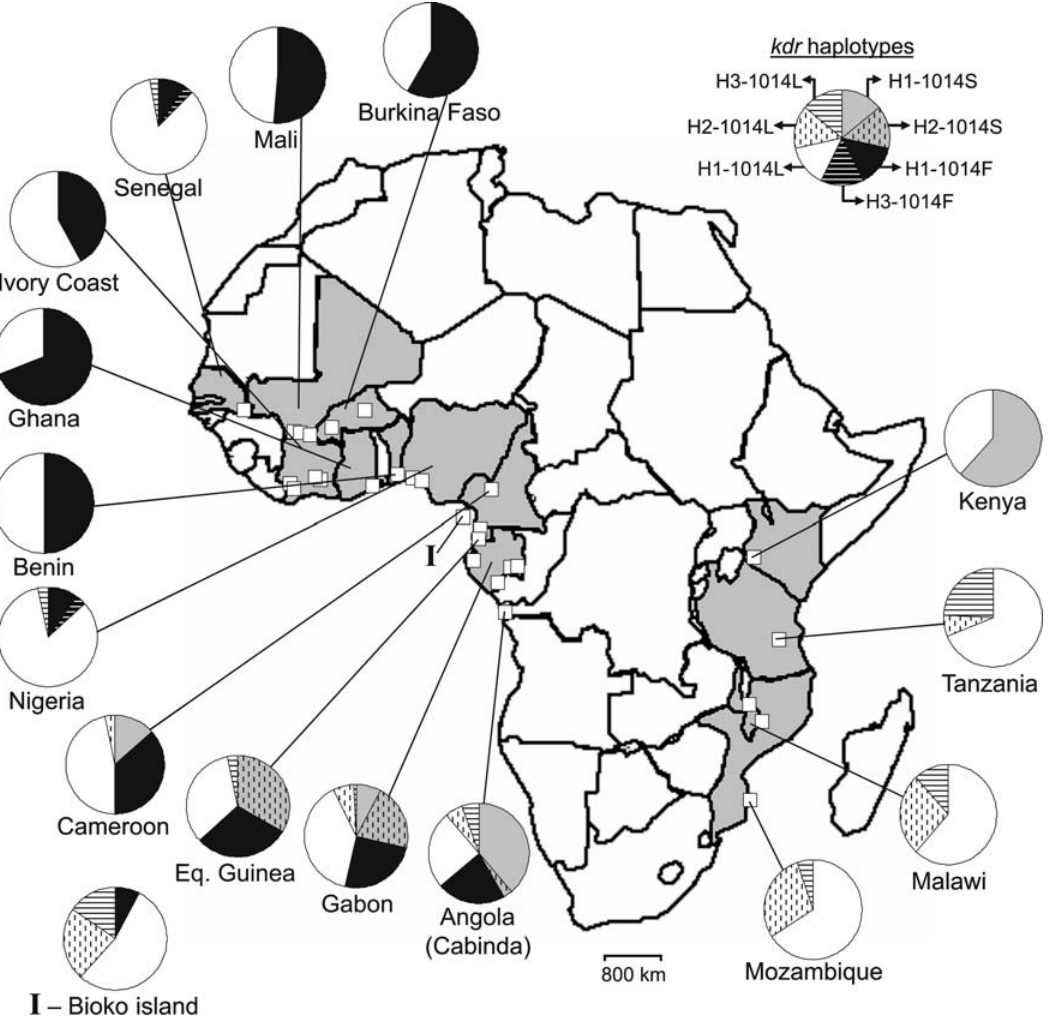
Figure 1. Geographic distribution of kdralleles and most common intron-1 haplotypes of A.gambiae. Gray-shaded countries are those included in the study. White squares in the map are the approximate locations of collection sites. Pie charts show the relative frequencies of kdr haplotypes ( i.e. kdr alleles and corresponding intron-1 haplotypes), per country. Labels for each kdr haplotype are shown in the example pie chart, at the upper-left corner of the